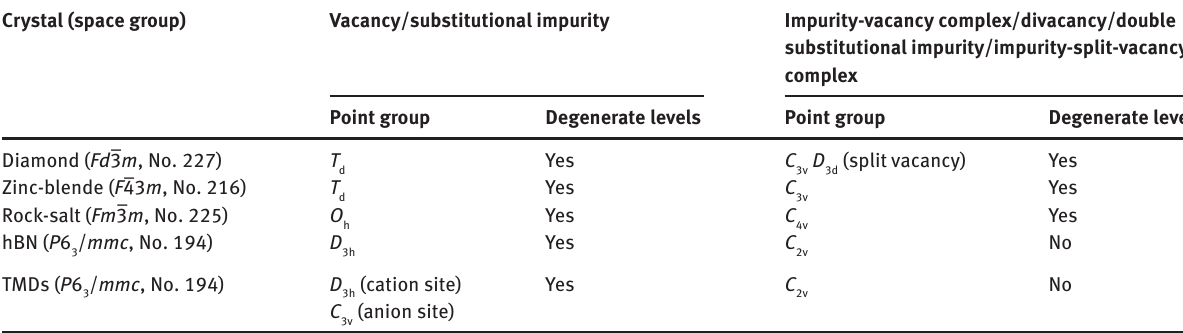
Table 2: Selected properties of two types of defects in various crystals. Crystal (space